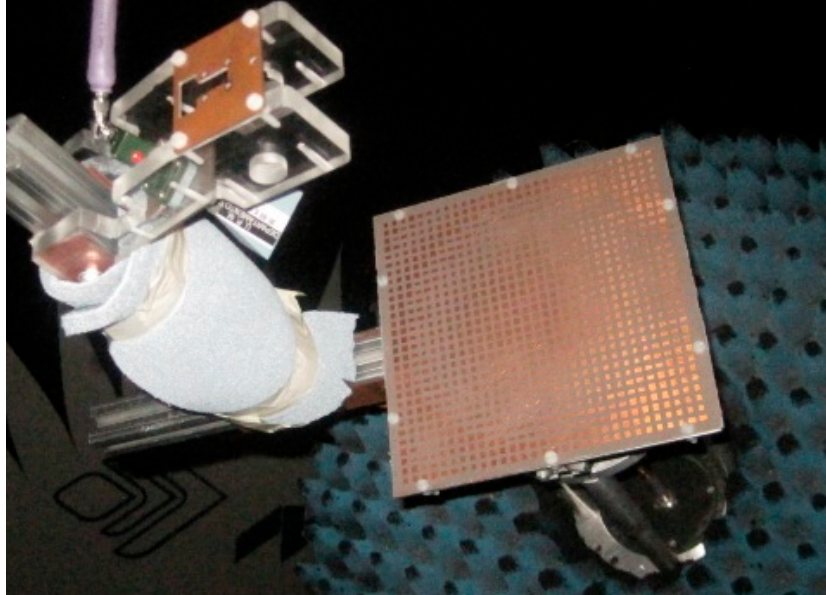
Figure 7. Picture of the fabricated reflectarray antenna at the anechoic chamber.